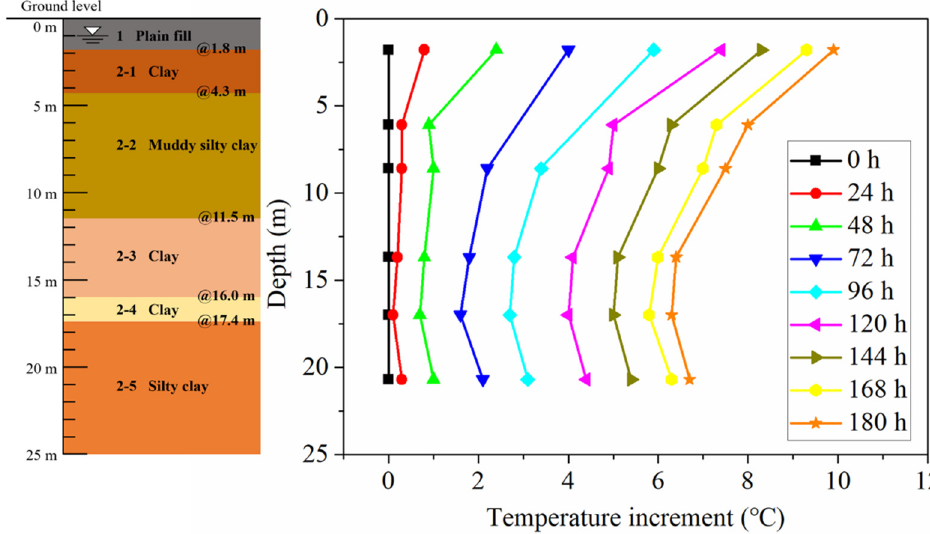
Figure 6. Ground temperature increment at different running times in BH1.